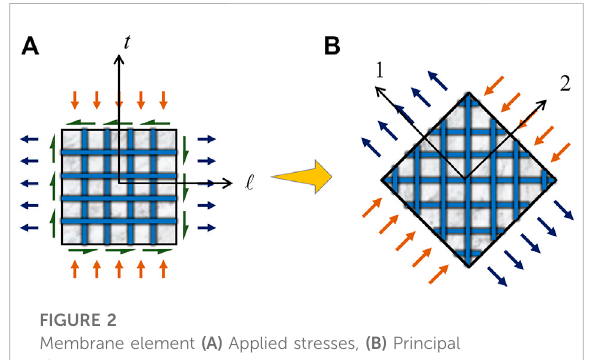
FIGURE 2 Membrane element (A) Applied stresses, (B) Principal